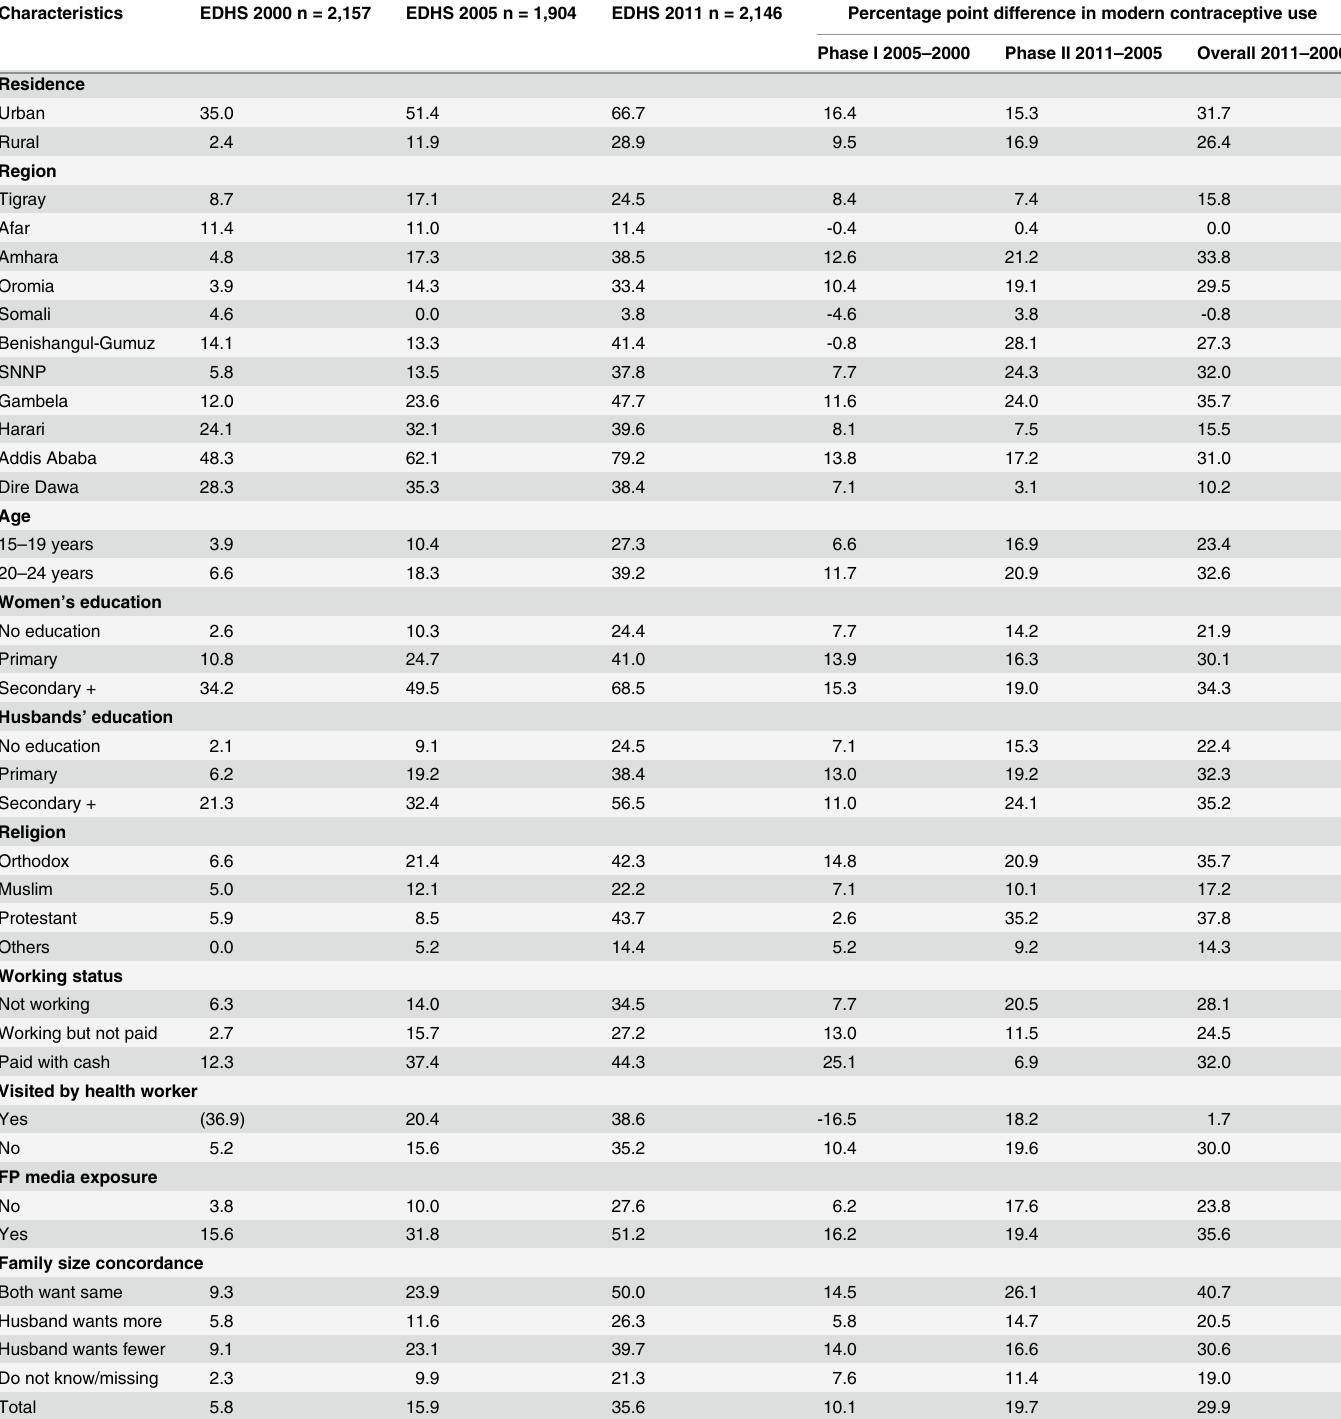
Table 3. Trend in modern contraceptive use among young currently married women by selected characteristics, 2000, 2005, and 2011 Ethiopia Demographic and Health Surveys.